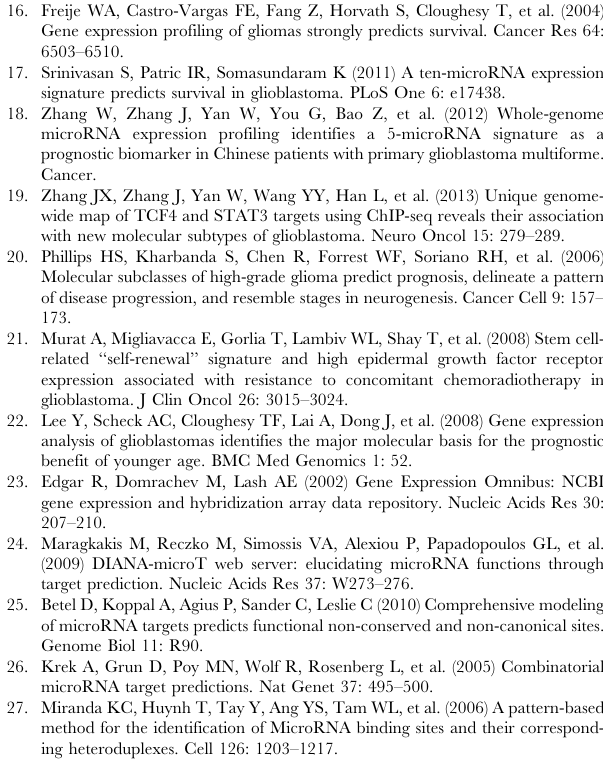
Figure S3 Hierarchical clustering on the glioma core survival module and four representative sub-modules. Figure S4 The moduleS3 signature predicts the clinical outcome of samples from the Testing set using nearest centroid classification method. ( A ). Testing set grade II/III/ Figure S5 The 26-gene signature from moduleS3 pre- dicts the clinical outcome of samples from TCGA dataset. Figure S6 The recurrence ratio of glioma miRNA-gene module results after partial sample perturbation analysis. Figure S7 The shuffle-and-split analysis of our expres- sion signatures. The recurrence ratio of core gene signatures in